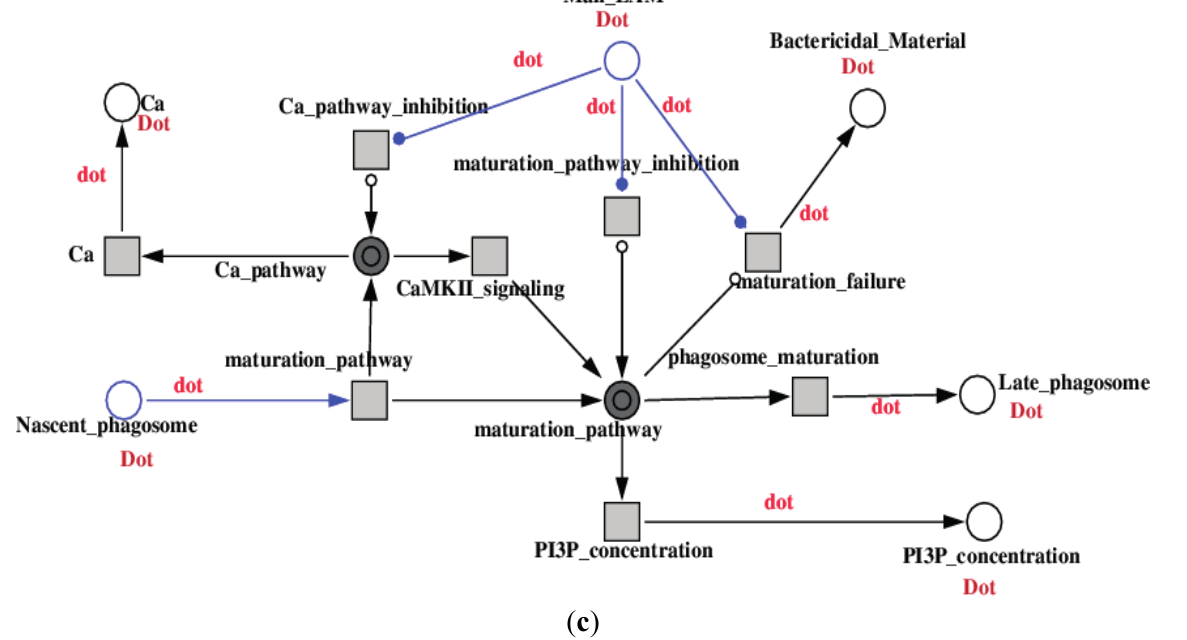
Figure 5. Submodels in the hierarchical structure: ( a ) Level 2: Intercellular interaction between bacteria and macrophage. ( b ) Apoptosis_Pathway and ( c ) Phagosome_Maturation_Pathway represent the intracellular interaction positioned at level 3. Level 4 represents the molecular interactions defined in [23]; they are modeled in the coarse places and coarse transitions (data not